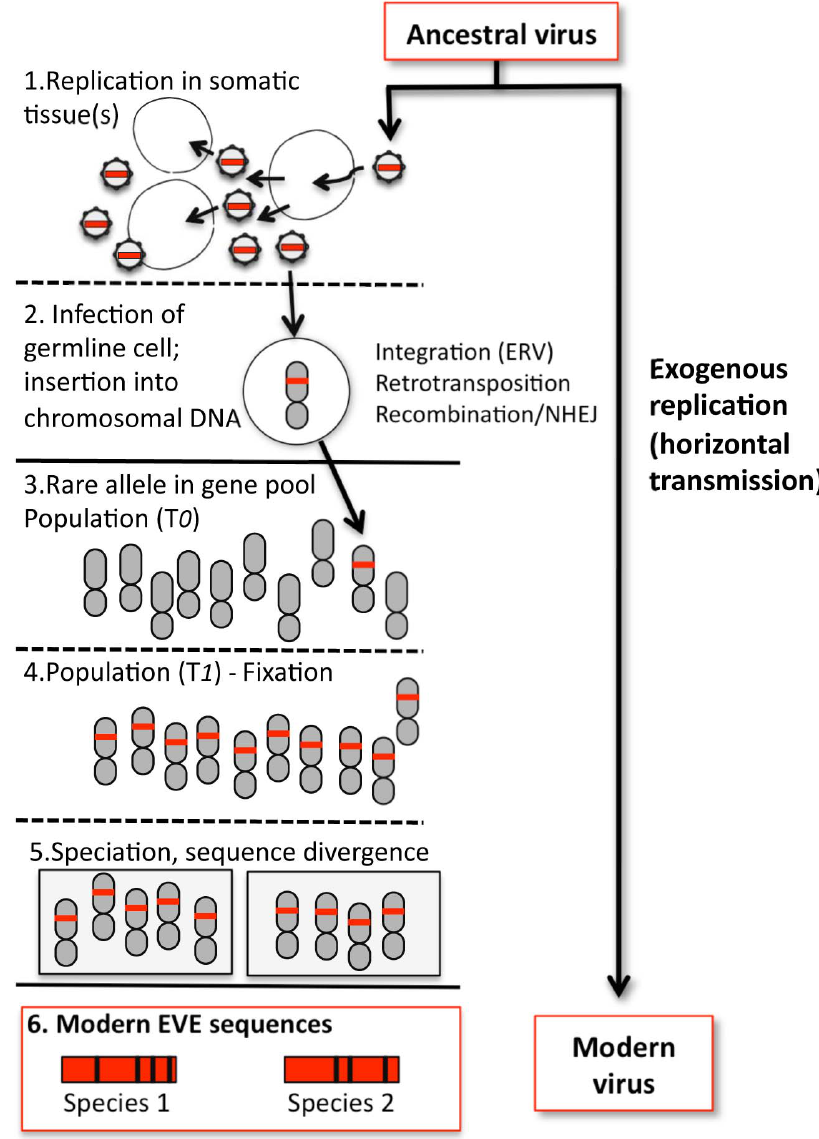
Figure 1. Formation of a hypothetical EVE and relationship to modern viruses. 1. An ancestral virus spreads in a host population, infecting and replicating in somatic tissue(s) of infected individuals. 2. Occasionally, a virion may encounter a germline cell (or any cell in the developmental pathway leading to germline tissue); in some cases viral sequence is inserted into chromosomal DNA. For retroviruses, integration is an essential step in viral replication; for other viruses, insertion is a rare by-product of replication and must be mediated by other mechanisms, such as retrotransposition in trans or recombination. In addition, any given virus may not efficiently infect or replicate well in such cells, reducing the probability of insertion. Likewise, infections or insertions that are deleterious to the cell or tissue will reduce theprobability of vertical transmission. 3. If gametes bearingthe insertion are formed and the chromosome bearing the viral sequence is inherited, the insertion initially exists as a rare allele (the majority of individuals lack the insertion) and the fate of the newborn EVE is similar to any other chromosomal mutation, subject to loss or fixation by random genetic drift (if the insertion has phenotypic consequences,natural selectionmay also play a role).4.Moreoften than not, EVEsare probably lost by chance. On rare occasions, an insertion may drift towards higher frequency. Early on, speciationevents and incompletelineage sorting can lead tofixation in some lineages but not others, andchance extinction of populations with the insertion can still lead to loss (only fixation is shown).5. In descendant species that share the insertion, the orthologous EVE loci will evolve independently. 6. The genetic distance between orthologous EVEs in the genomes of modern species reflects the time passed since the last common ancestor of these species, and provides a lower bound estimate of the time since insertion. Divergence between EVE sequences and the sequences of their modern viral relatives is the combined result of EVE evolution (as part of the nuclear genome) and exogenous viral evolution, the rates of which can differ by several orders of